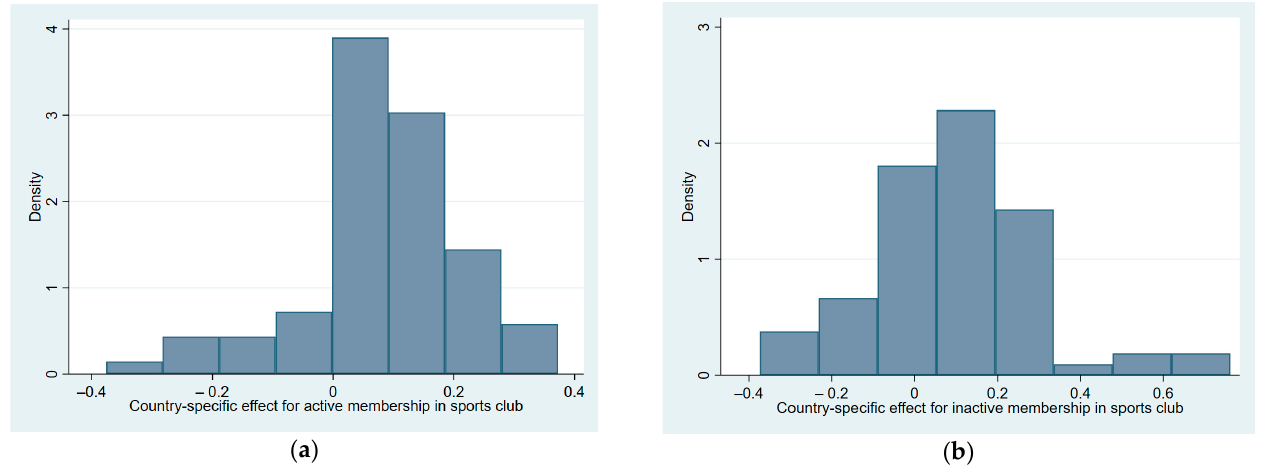
Figure 4. Estimated country-specific effects for active membership in sports clubs ( a ) and inactive membership in sports clubs ( b ) for the group of men. Source: WVS-EVS